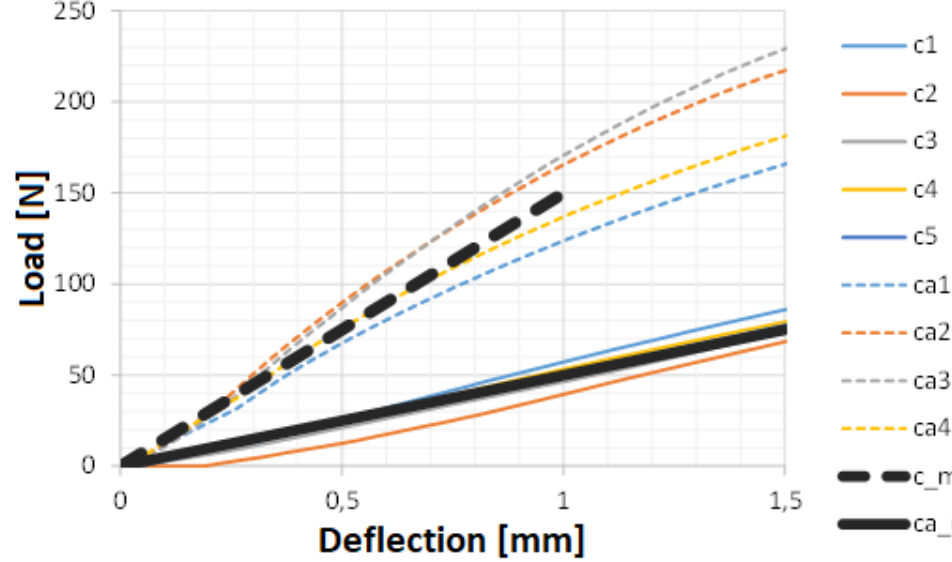
Figure 17. Elastic region: load vs. mid-span deflection measured for both types of sample (c_m and ca_m represent the respective mean values).